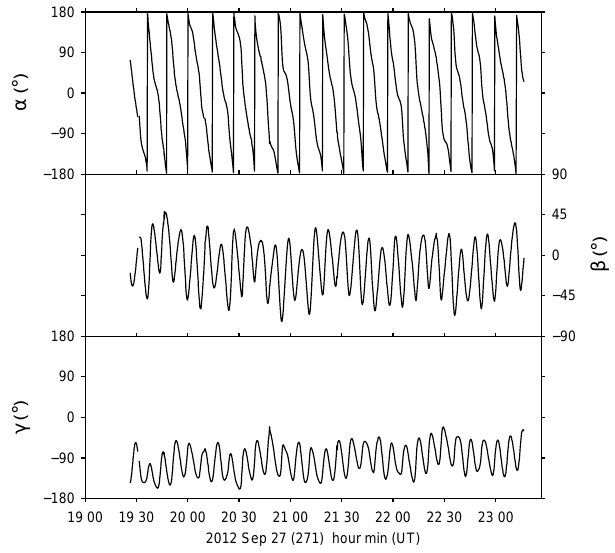
Figure 5. Determined attitude of the inboard MAGIC sensors, rep- resented as the three Euler angles.